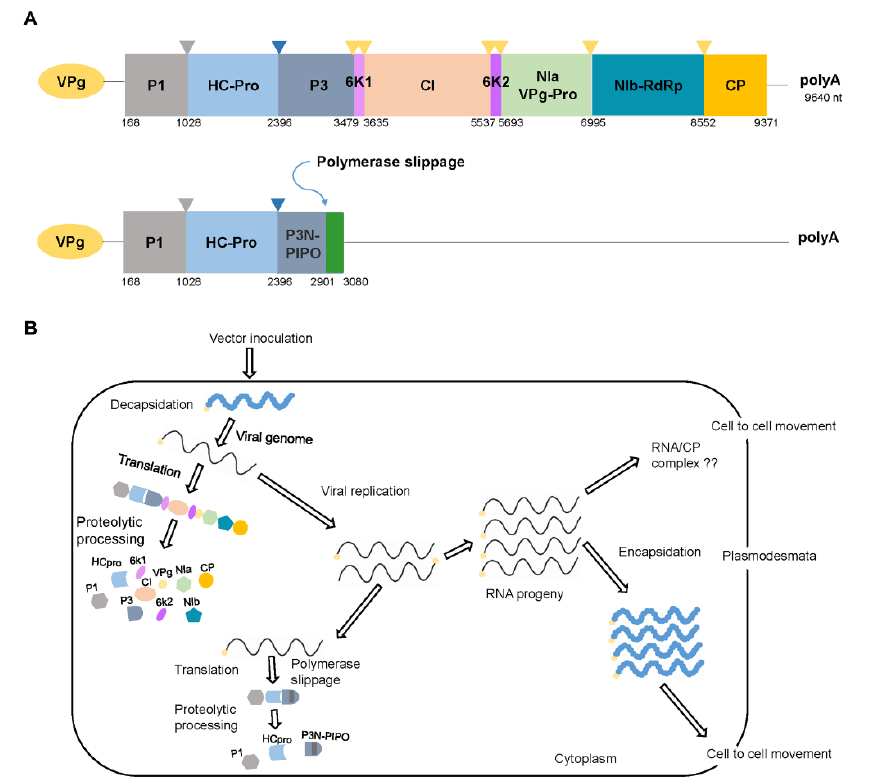
Figure 1. Genome organization and schematic representation of replication of pepper mottle virus (PepMoV). ( A ) The genomic maps of PepMoV. The genome is translated into a large polyprotein that is catalyzed by three potyviral proteases (P1, HC-Pro, and NIa) and cleaved into 10 mature viral proteins (marked in different colors). The next depicted represents a short open reading frame, termed P3N-PIPO, embedded within the P3-encoding region of the polyprotein. ( B ) Schematic representation of replication in a plant cell. The cycle begins (left upper corner) when the viral particle or RNA enters the cell from infected cells or initially inoculated by its vector. The genomic RNA undergoes decapsidation, translation, and proteolytic processing to generate mature proteins. The replication complex uses the positive genomic RNA to generate a complementary negative genomic RNA, which functions as a template for the synthesis of numerous genomic RNAs. After replication, the progeny RNAs can be encapsidated and acquired by vectors to be transmitted again, or they can move to adjacent cells through plasmodesmata.